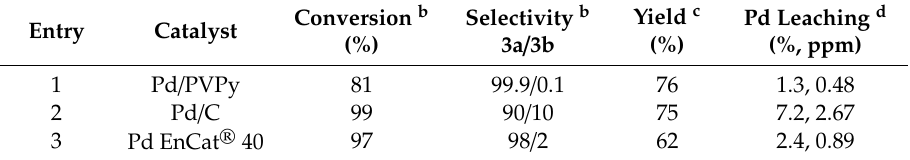
Table 3. Comparison of the performances of Pd / PVPy in the Suzuki–Miyaura reaction a . Conversion b Entry Catalyst